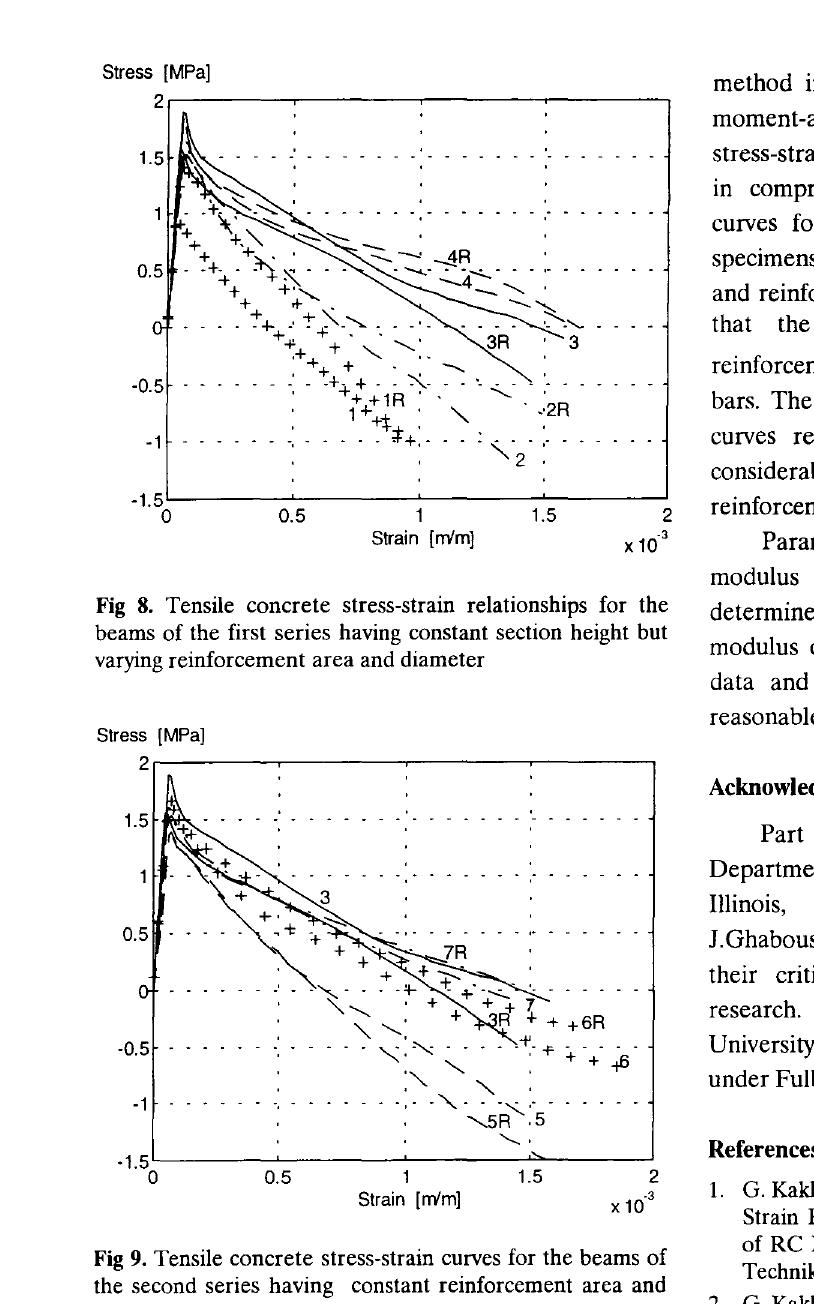
Fig 9. Tensile concrete stress-strain curves for the beams of the second series having constant reinforcement area and diameter but varying section